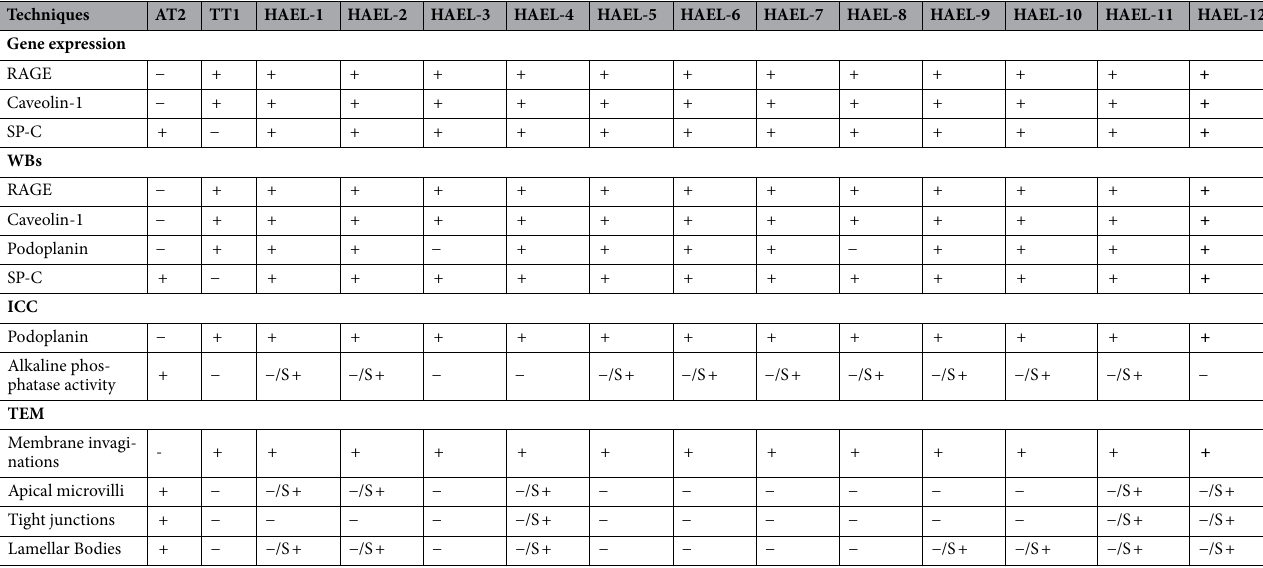
Table 2. Summary of characteristic features positively expressed (+), negatively expressed (−) and negative with scattered positive expression (−/S +) in ICs compared with primary AT2 cells and the type 1 cell line (TT1). Gene expression data and data on the ultrastructure of AT2 cells were obtained respectively from Johansson et al. 28 and Bingle et al. 6